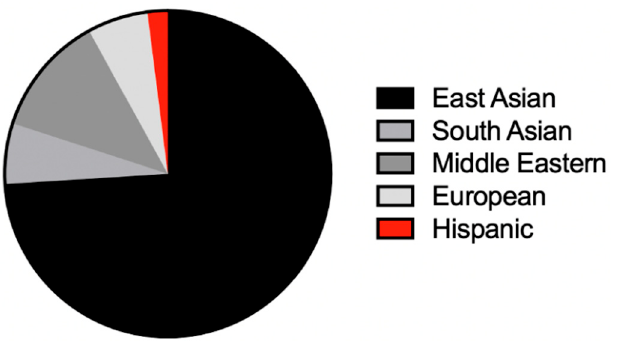
Figure 4. Pie chart depicting proportion of affected patients across major ethnic groups (N = 50). Asian (Chinese ( n = 32), Japanese ( n = 5)), South Asian (Indian ( n = 3)), Middle Eastern (Moroccan East Asian (Chinese (n = 32), Japanese (n = 5)), South Asian (Indian (n = 3)), Middle Eastern (Moroc- ( n = 3), Sephardic Jewish ( n = 2), Tunisian ( n = 1)), European (Italian ( n = 3)), and Hispanic (Cuban can (n = 3), Sephardic Jewish (n = 2), Tunisian (n = 1)), European (Italian (n = 3)), and Hispanic (Cuban ( n = 1)). (n = 1)).